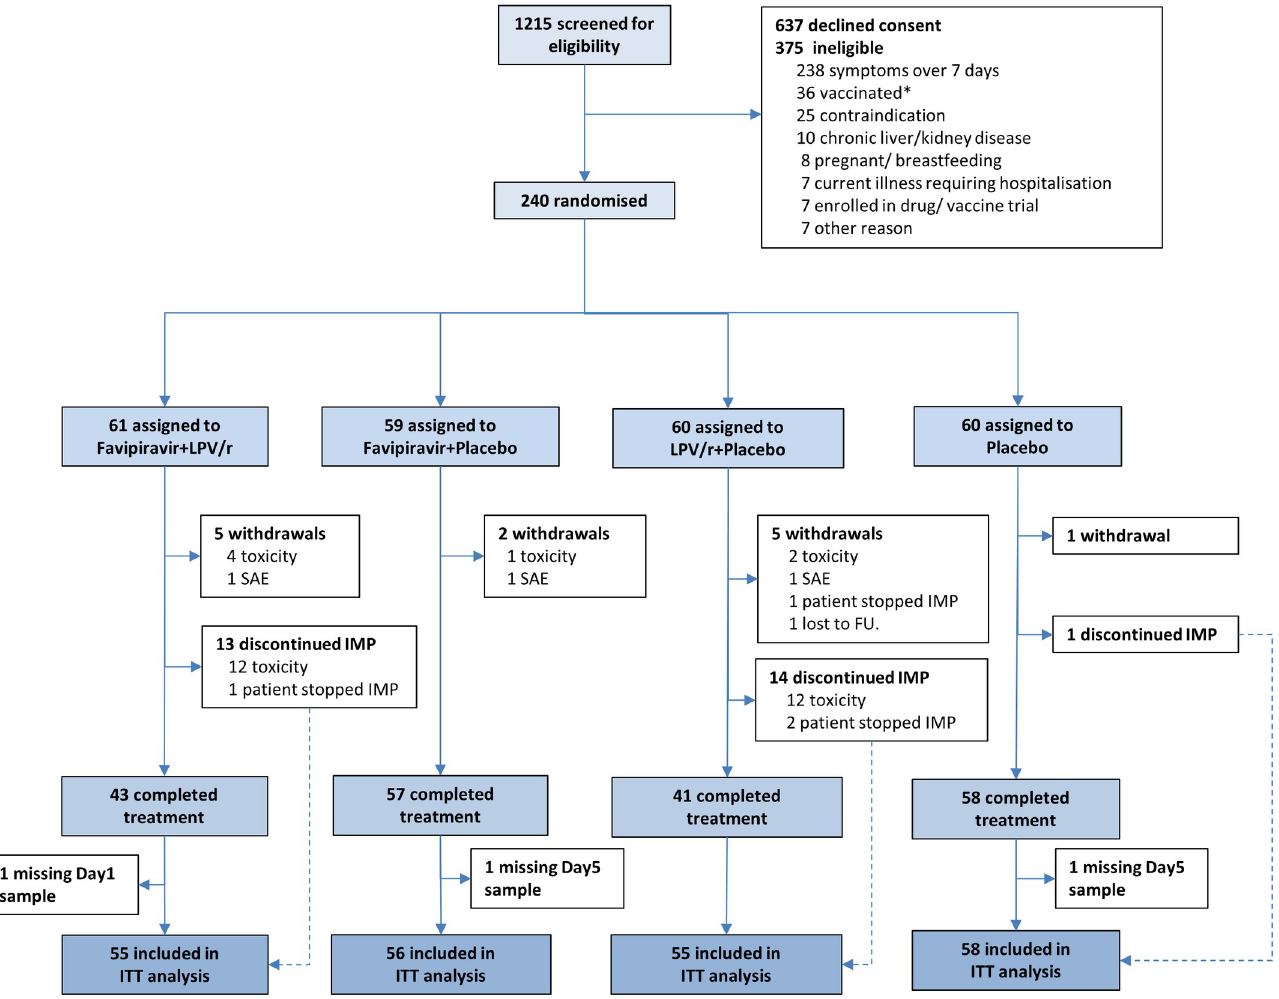
Fig 1. CONSORT diagram for the FLARE trial. � SARS-CoV-2 vaccination was an exclusion in the earlier part of the trial. FU, follow-up; IMP, investigational medicinal product; ITT, intention-to-treat LPV/r, lopinavir-ritonavir; SAE, serious adverse event; SARS-CoV-2, Severe Acute Respiratory Syndrome Coronavirus 2.